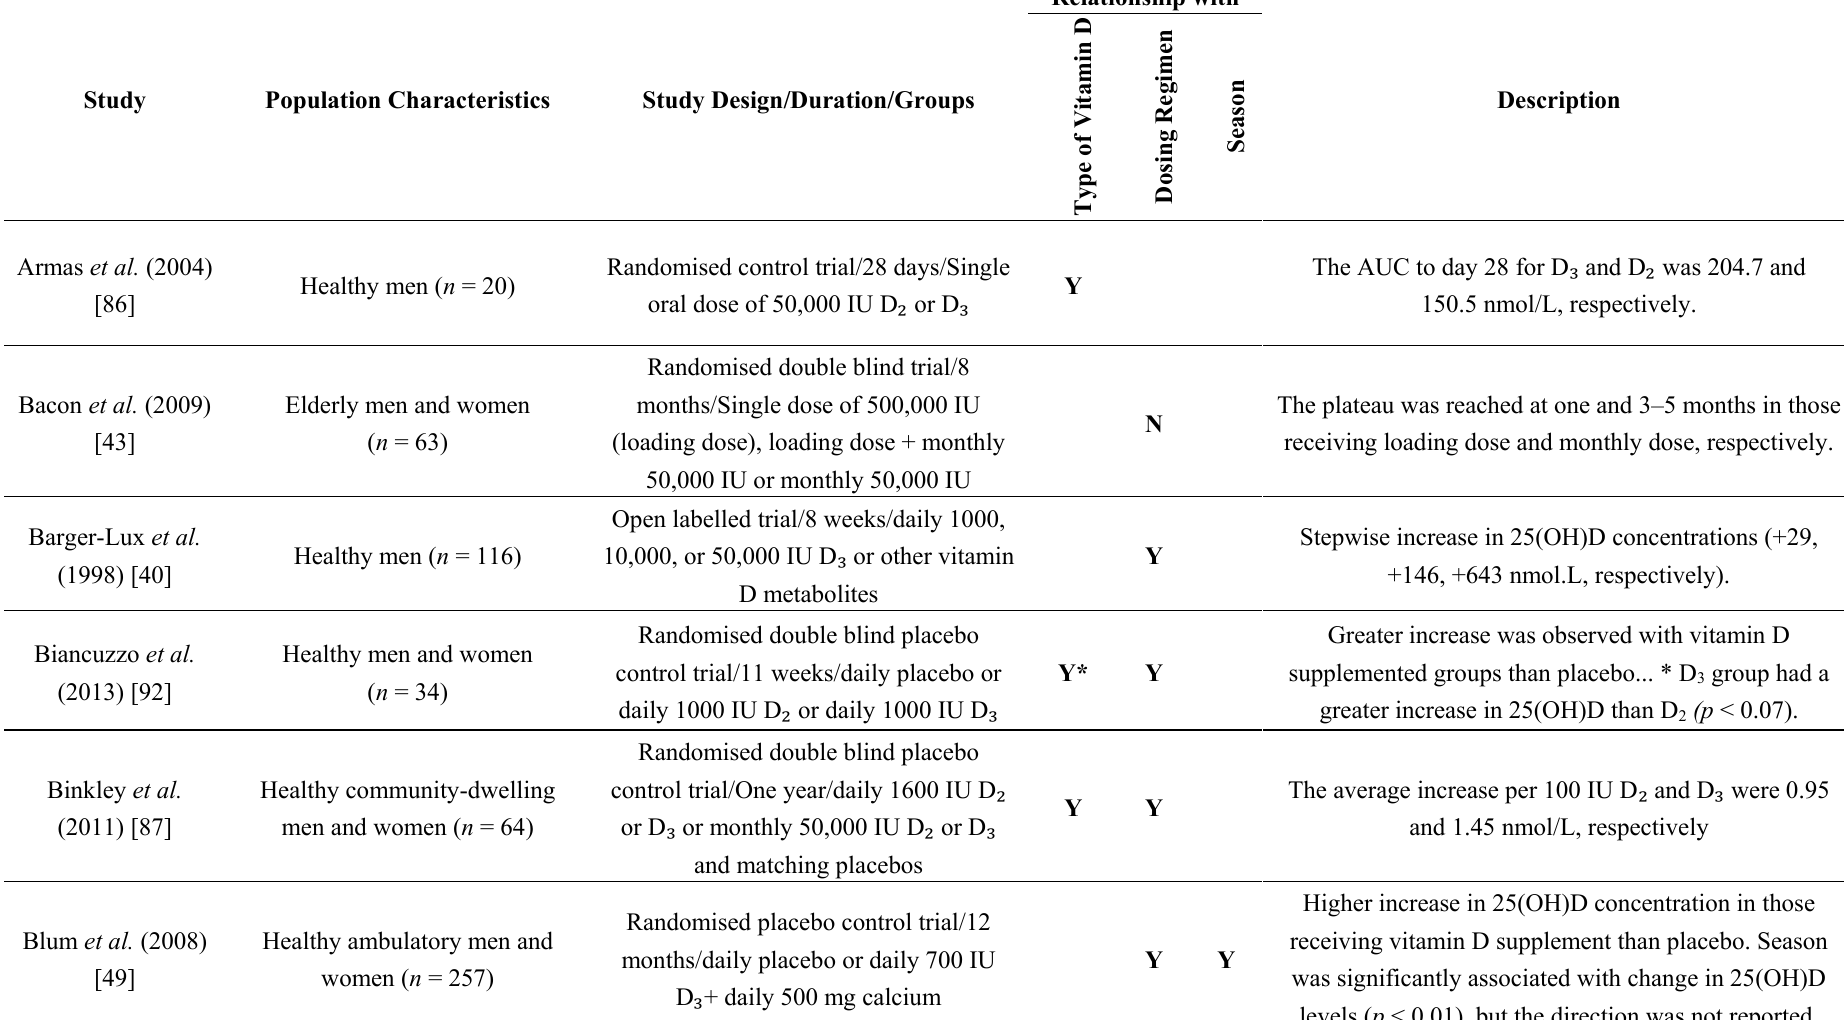
Table 2. Treatment and environmental factors predicting circulating 25(OH)D response to vitamin D